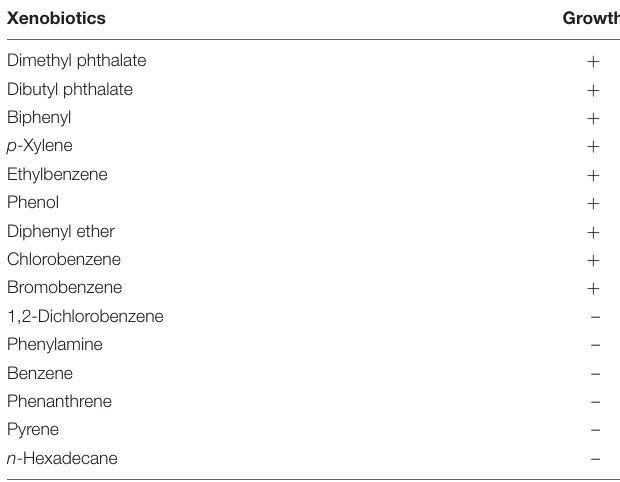
TABLE 1 | The xenobiotic-degrading ability of strain C1 T